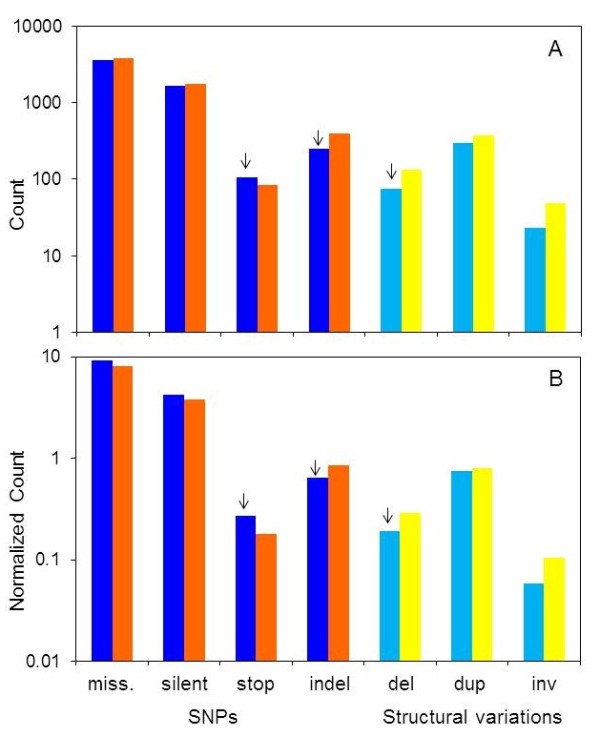
A summary of the genomic variation counts in intact OR coding regions and in OR pseudogenes.A, The absolute count. B, Count normalized per gene. Intact genes, blue and light blue; pseudogenes, orange and yellow. Nonfunctional variations are indicated by arrows. Abbreviations: miss, missense SNP; indel, small insertion/deletion up to 100 bp; del, CNV deletion; dup, CNV duplication; inv, CNV inversion; stop, stop gain/stop loss/ loss of the initiating methionine.